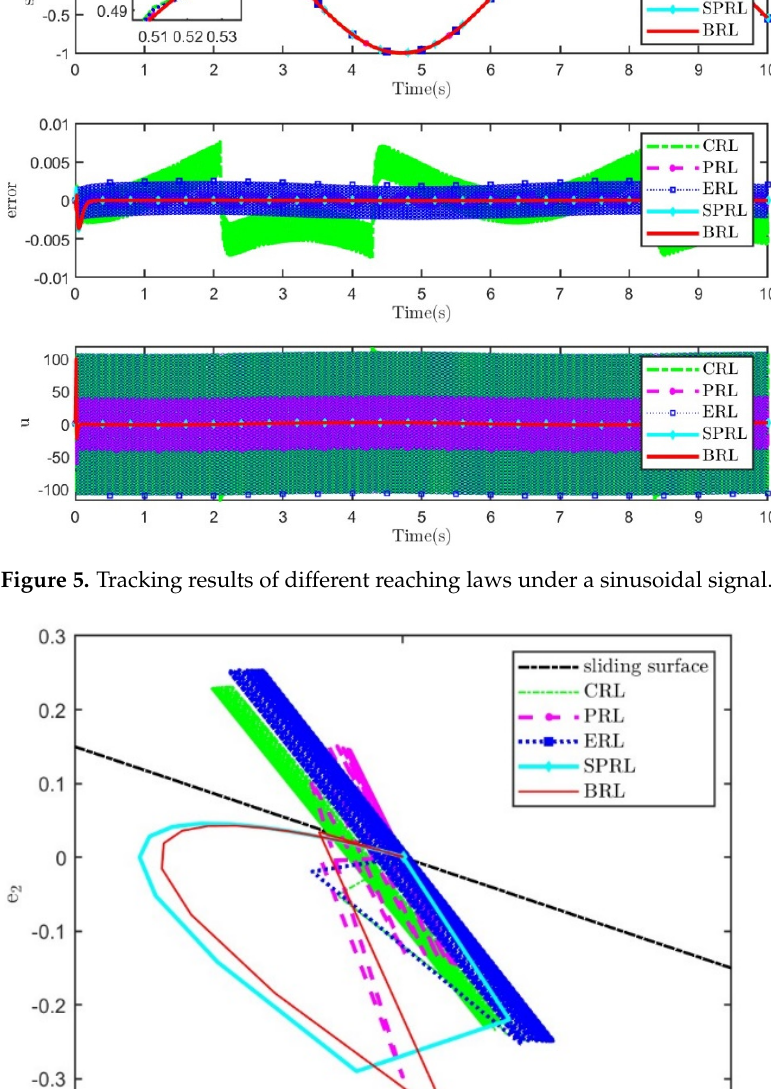
Figure 6. Sliding mode motions for different reaching laws under sinusoidal signals.